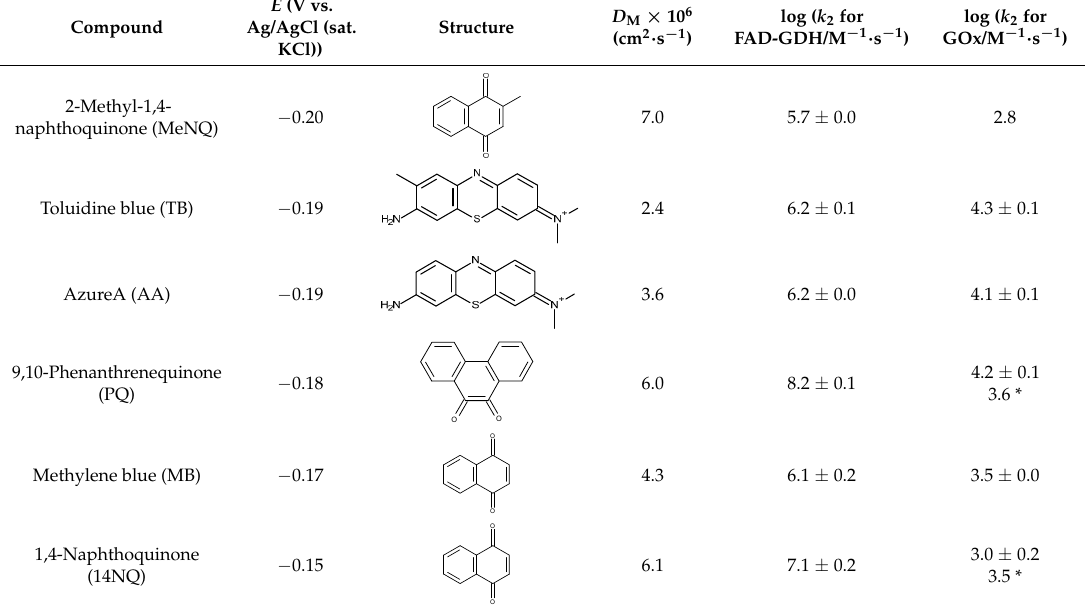
Table 1. Redox mediators and the enzyme oxidation rates measured at pH 7 and 25 °C. E (V vs. Ag/AgCl Compound (sat. KCl))